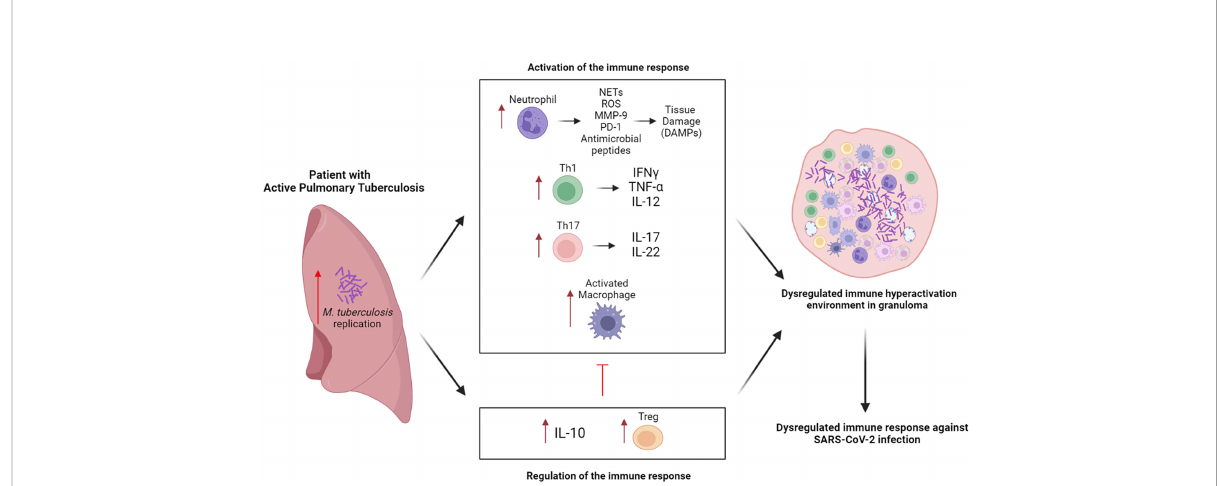
FIGURE 1 The immune response in COVID-19 and active tuberculosis. The Th1 response potentiates macrophage activity and the Th17 response favors the recruitment and activation of neutrophils with release of harmful products to the host tissue, further exacerbating the in fl ammatory process. To appease these responses, an elevated production of IL-10 and differentiation of Treg occurs, however, this generates a low immunologic potential. This response caused by M. tuberculosis generates an unfavorable immune microenvironment for theresnponse against SARS-CoV-2. Created with